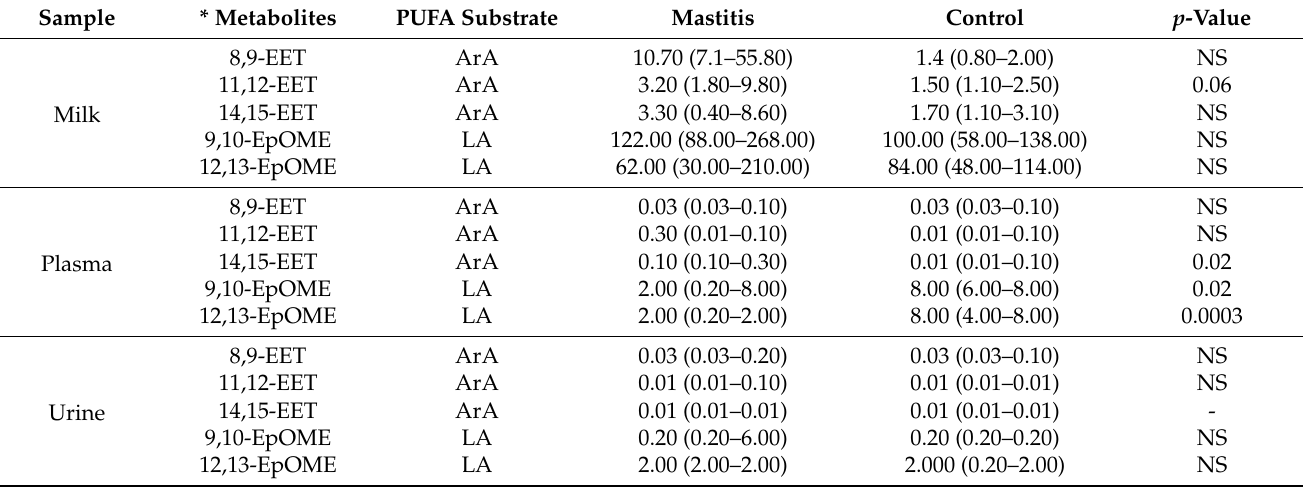
Table 2. Cytochrome P450-derived epoxy fatty acids (sEH substrates) in milk, plasma, and urine of systemic coliform mastitis and healthy control cows (median and range, n = 5/group).